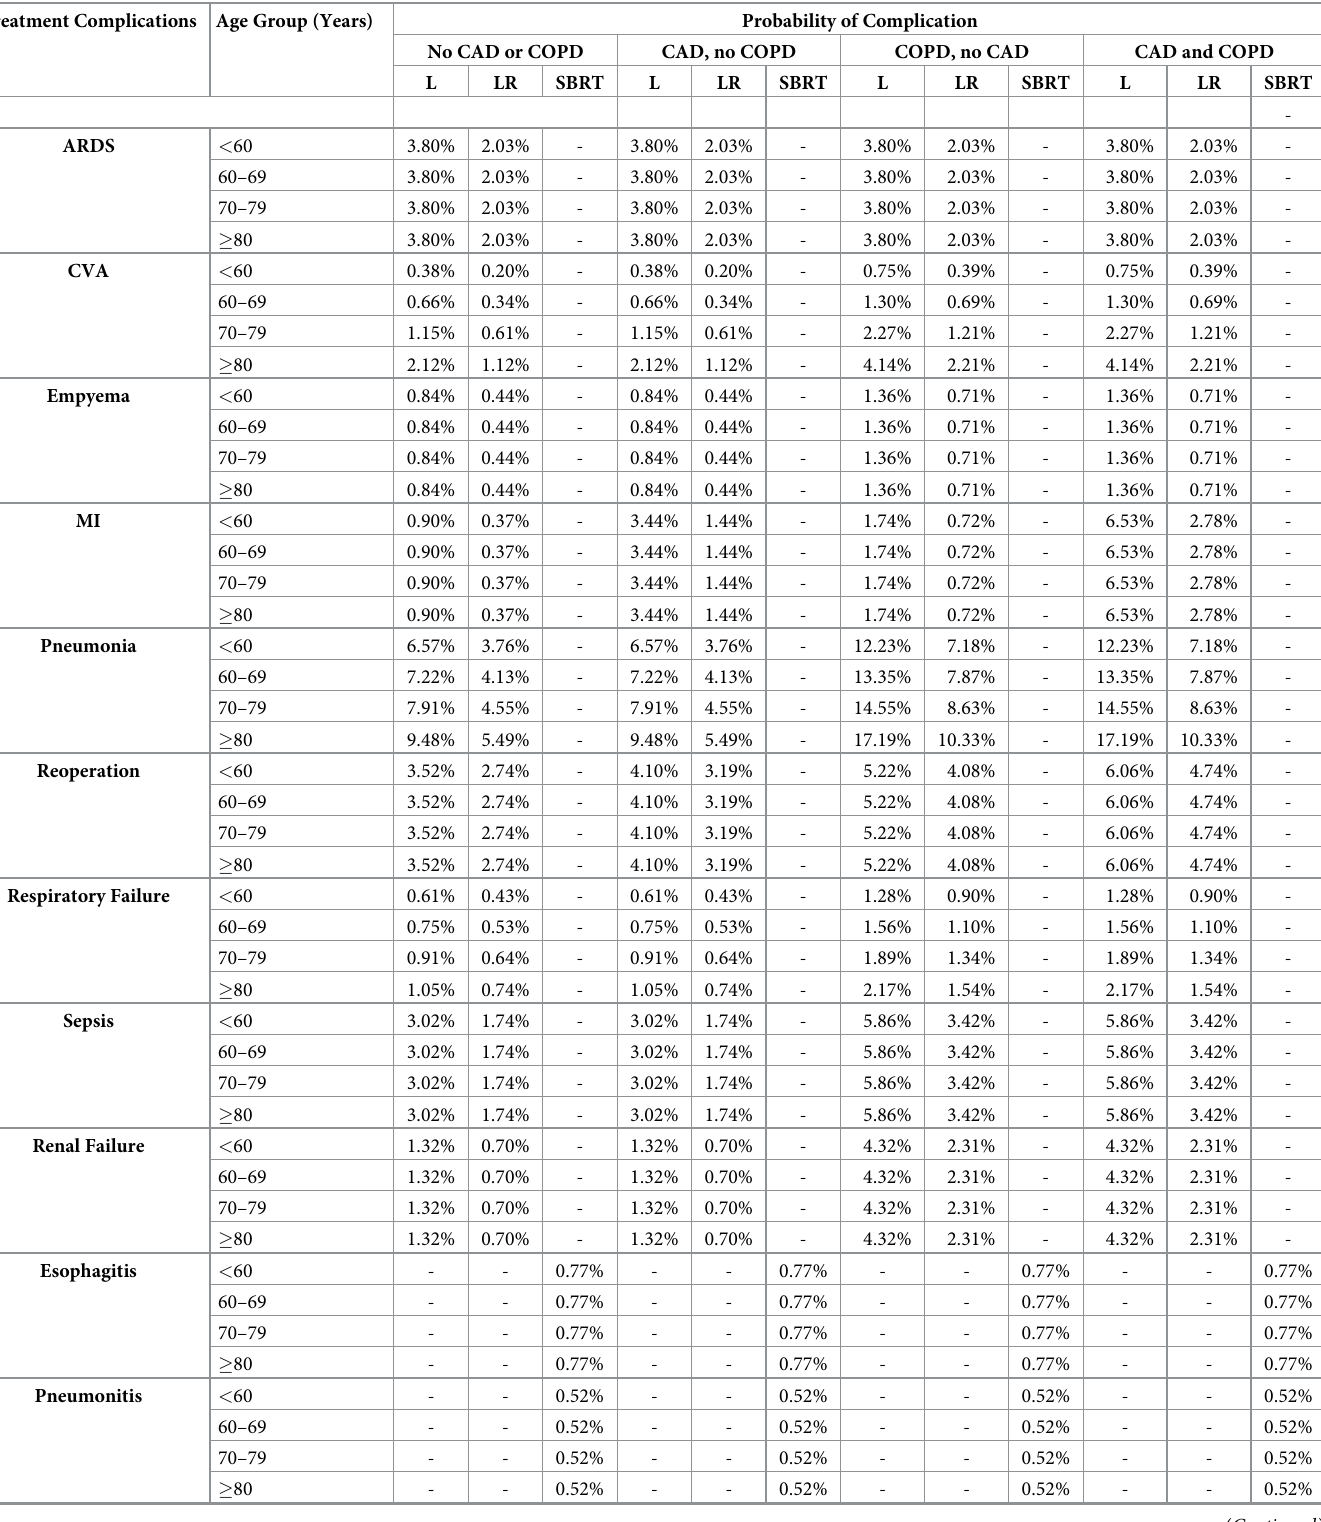
Table 3. Probability of major treatment